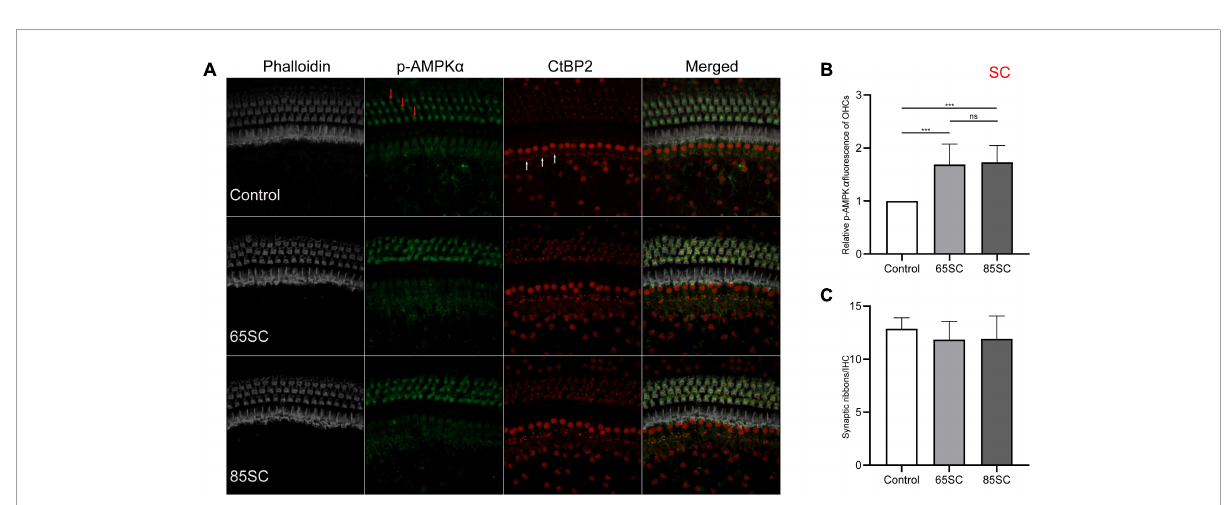
FIGURE4 Sound conditioning activated AMPK, and did not decrease ribbon synapses. (A) p-AMPK α fluorescence intensity in outer hair cells (red arrows) was increased relative to the unexposed control group on exposure to 65 or 85 dB SPL white noise for 1 week; CtBP2 (white arrows) was not significantly reduced. (B) Quantification of p-AMPK α immunolabeling indicating that sound conditioning may activate AMPK. There was no significant difference in p-AMPK α fluorescence intensity between the 65SC and 85SC groups. (C) Ribbon synaptic amount did not differ significantly between sound conditioning and control group animals. *** p <